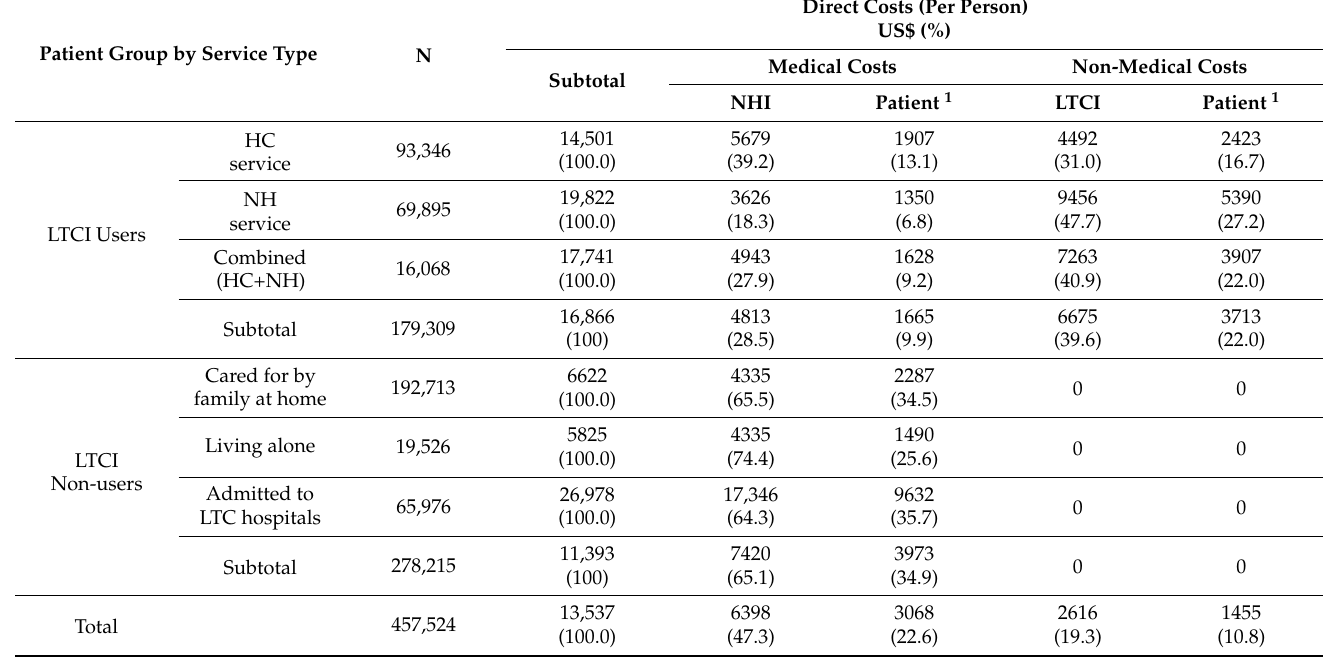
Table 3. Per-Person Direct